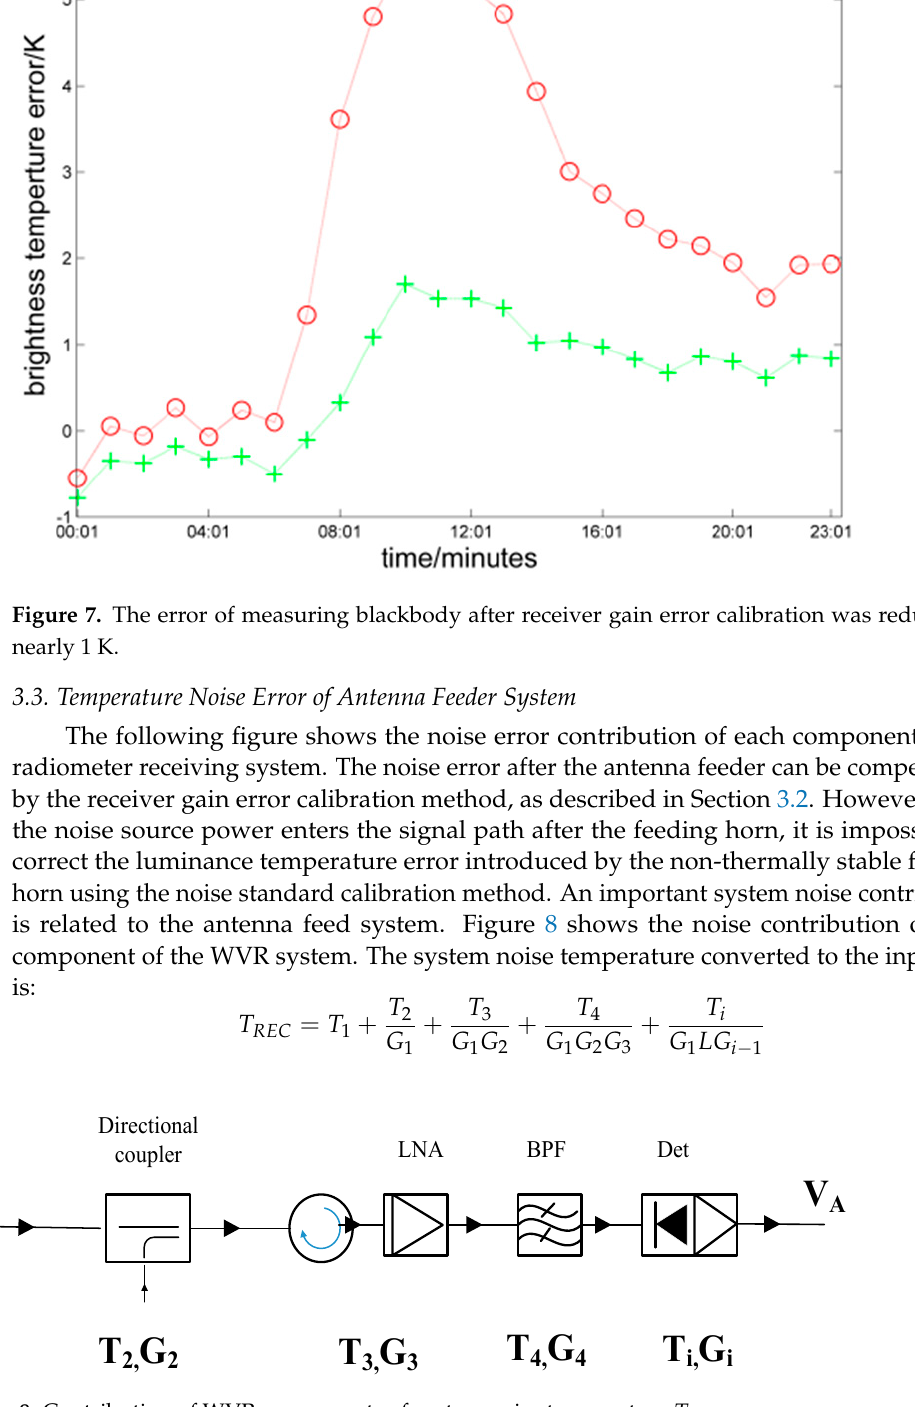
Figure 7. The error of measuring blackbody after receiver gain error calibration was reduced by nearly 1K.